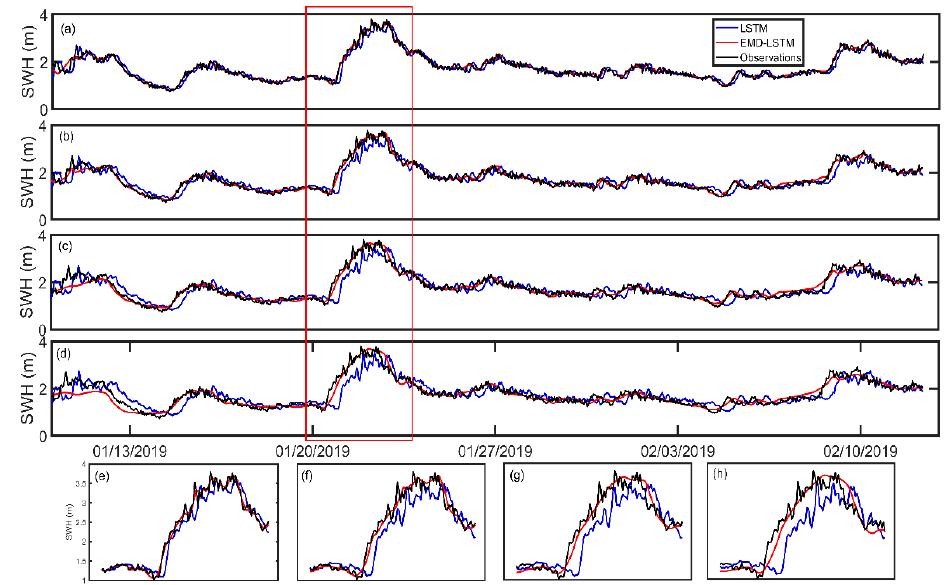
Figure 6. Comparison of LSTM (blue) and EMD-LSTM (red) significant wave height (m) forecasts with the observations (black) at the ( a ) 3, ( b ) 6, ( c ) 9, and ( d ) 12 h windows. The subplots provide a closer examination of deviations between observations and forecasts at the ( e ) 3, ( f ) 6, ( g ) 9, and ( h ) 12 h windows.